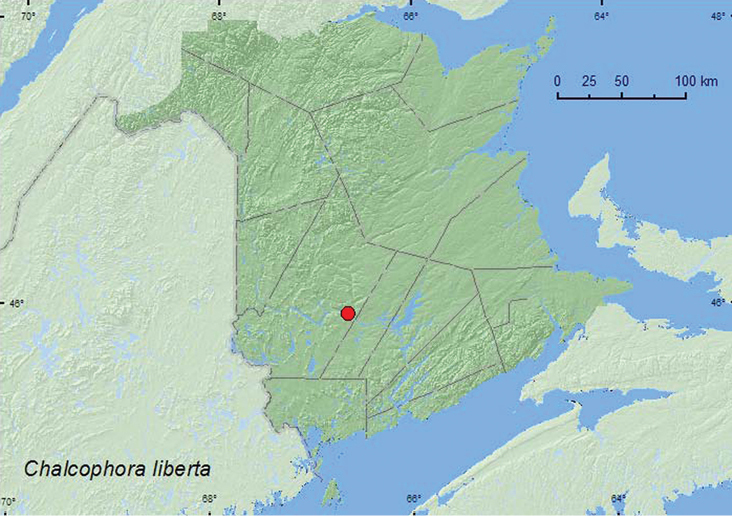
Collection localities in New Brunswick, Canada of Chalcophora liberta.